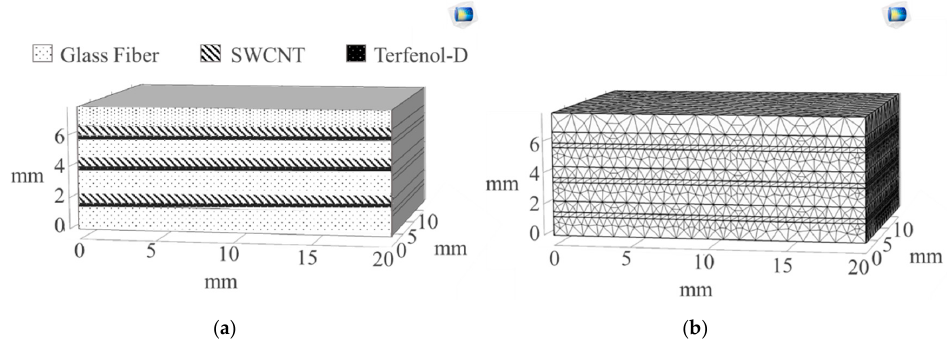
Table 1. Materials used on the COMSOL Multiphysics ® model and their properties.